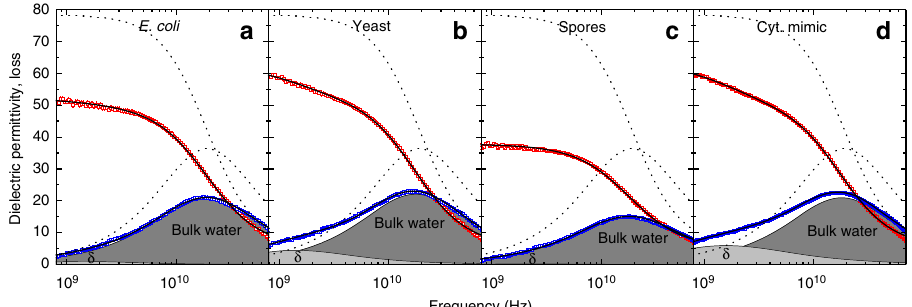
Fig. 3 Dielectric-relaxation measurements of water dynamics. Real ( red points ) and imaginary ( blue points ) parts of the dielectric permittivity of three cellular samples and cytosol mimic (pH 7, with protein). The dashed curves show the permittivity of neat water. The solid curves are least-squares fi ts of a sum of two Cole – Cole modes to the data (see Supplementary Table 3 for the fi t parameters). The shaded areas indicate the two contributions to the dielectric loss: bulk water and δ -relaxation. For clarity the Ohmic loss contribution (see Supplementary Discussion 2) has been subtracted